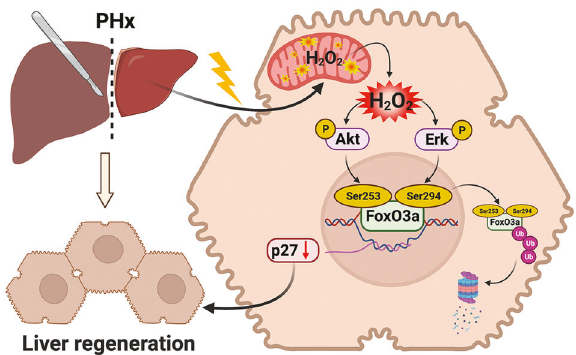
Fig. 7 Schematic representation of mitochondria-derived H 2 O 2 triggering liver regeneration via FoxO3a signaling pathway after partial hepatectomy in mice. After PHx, the mitochondria-derived H 2 O 2 increased the phosphorylation of FoxO3a at the speci fi c sites (Ser253 and Ser294) by activating both Akt and Erk, thus reducing transcription and expression of its target p27 in the downstream, a key cell cycle inhibitor, leading to the cell proliferation and LR. (This artwork was created at